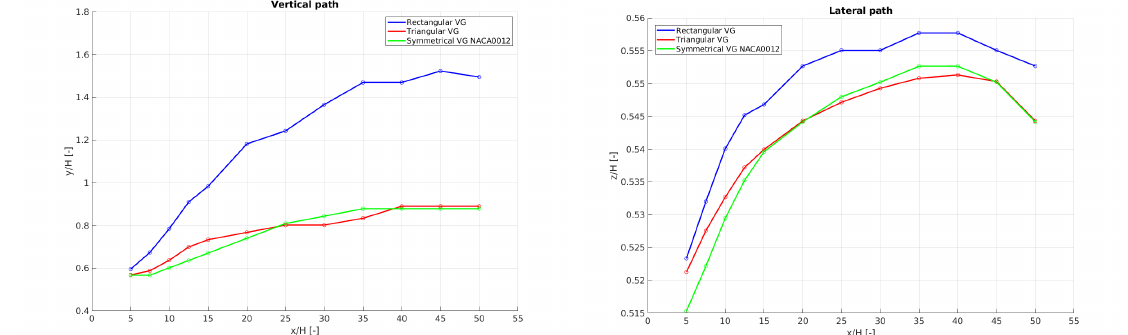
Figure 10. Trajectory of the primary vortex from a streamwise position from 5H to 50H. On the left vertical path in normalized vertical coordinate. On the right, lateral path in normalized lateral coordinate.